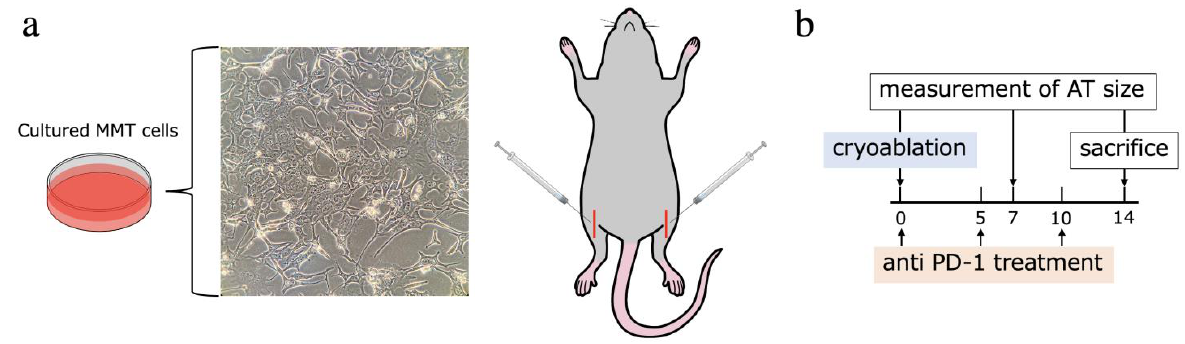
Figure 8. ( a ) Cultured MMT cells and schema of implantation of MMT suspended in Matrigel. ( b ) Schedule of treatment interventions and measurement of AT size. MMT, mouse mammary tumor; AT, abscopal tumor.